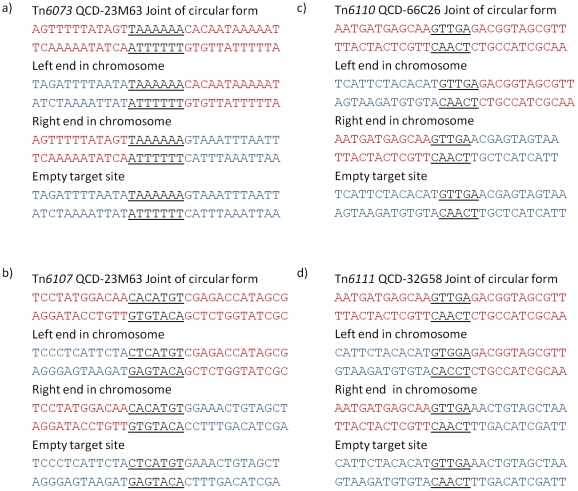
Sequences of the joints of circular intermediates element-genome junctions and regenerated target sites after excision.Sequence in red is part of the transposons, blue is part of the chromosome. Terminal repeats are underlined. a) Tn6073 QCD-23M63, b) Tn6107 QCD-23M63, c) Tn6110 QCD-66C26, d) Tn6111 QCD-32G58.